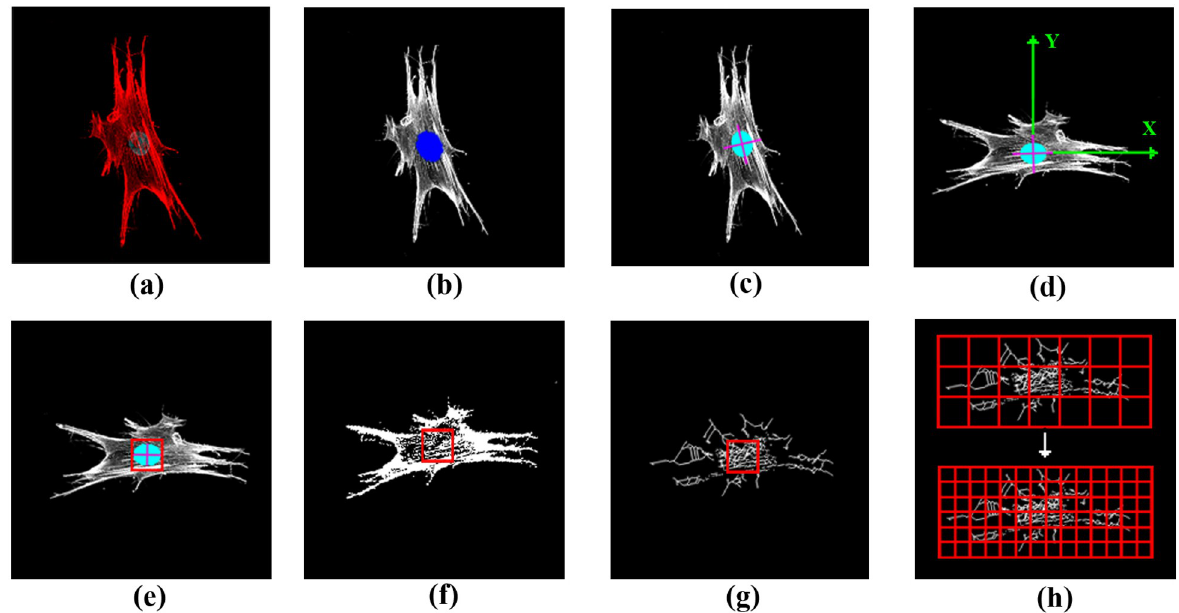
Fig 1. Step-by- step image processing algorithm for FD calculation. (a) The original two-channel image of the cell (F-actin and cell nucleus stained with Rh-Ph and Hoechst, respectively) was captured in 2048 x 2048-pixel resolution. (b) The blue channel (DAPI, cell nuclei) of the original image was isolated, binarized and color filled. (c) The minor and major axes of ellipse approximating the cell nuclei were found. (d) The original image is rotated in order that the major axis of ellipse becomes parallel to the X axis of the image. (e) The initial size of box grid is chosen as smallest square with power of two in which the ellipse approximating the cell nuclei is inscribed. The center of the box is in the ellipse’s centroid. The red channel (F-actin, Rh-Ph) of the original image is binarized (f), skeletonized (g) and processed using box counting method (h) using the calculated box size (e) in an initial